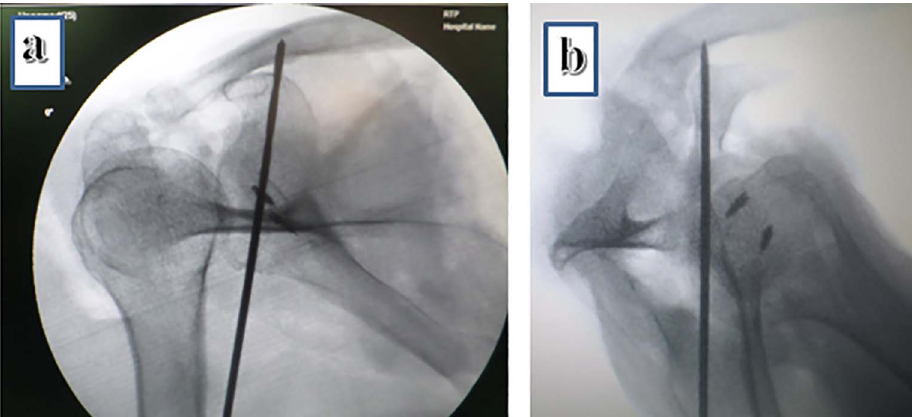
Figure 4. Fluoroscopic control of screw position. (a) Ideal screw position in coracoid base view. (b) Ideal screw position in scapular Y view (images showing anchors previously implanted in cadaver